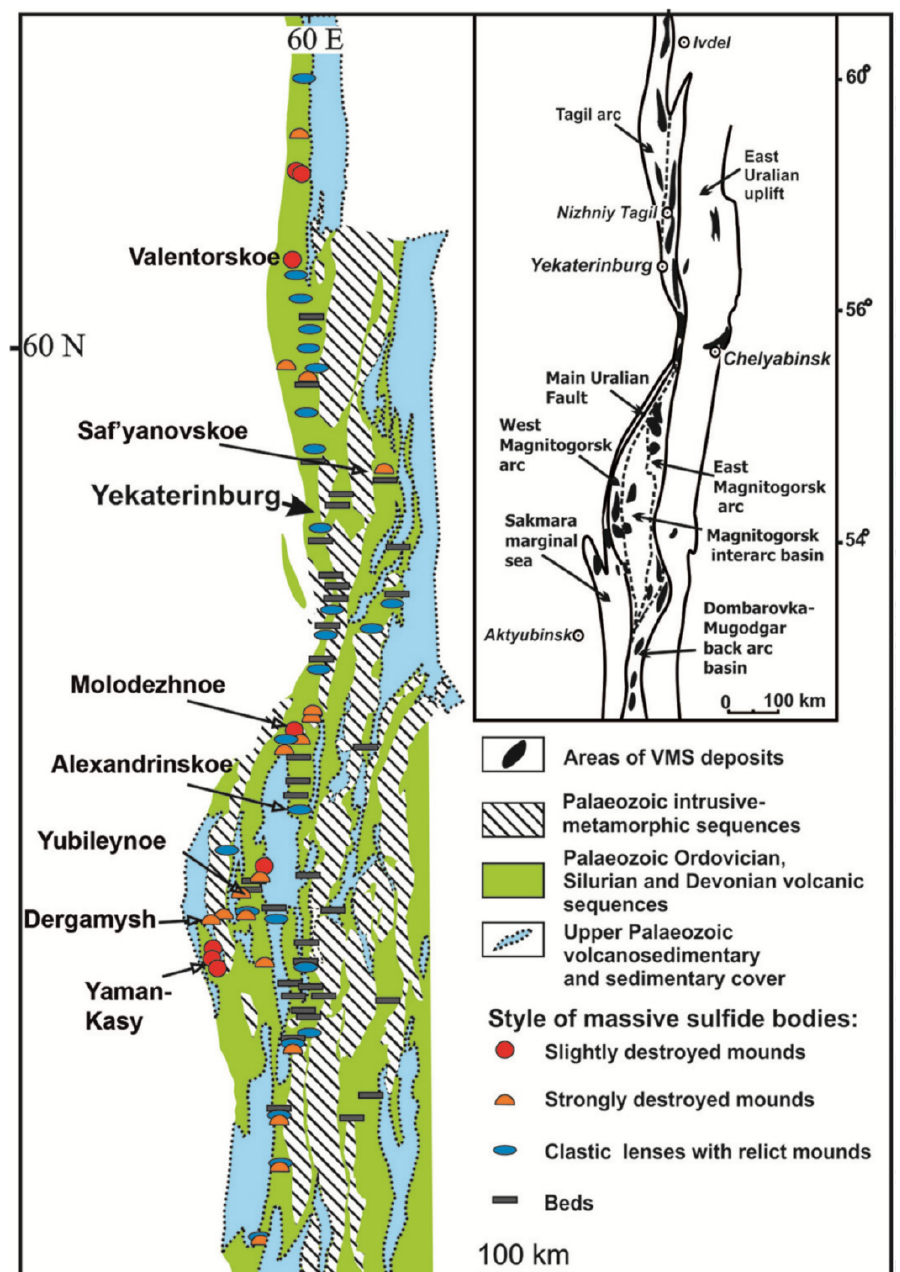
Figure 1. Geological position of the Urals volcanic-hosted massive sulfide (VHMS) deposits (modified after [19,45,46]). In the Urals, the deposits are subdivided into five types: Atlantic, Cyprus, Uralian, Baymak, and Rudny Altay, see Figure 2 [35,36,39,41,42,45–50]. This classification can broadly be compared to the classification of Franklin et al. (2005), where Cyprus type is mafic, Uralian type is bimodal-mafic and Baymak and Rudny Altay types are bimodal-felsic types of deposits [51]. In this paper, we consider examples of weakly metamorphosed deposits of Atlantic, Uralian, Baymak, and Rudny Altay types only, avoiding the complexities of metamorphic